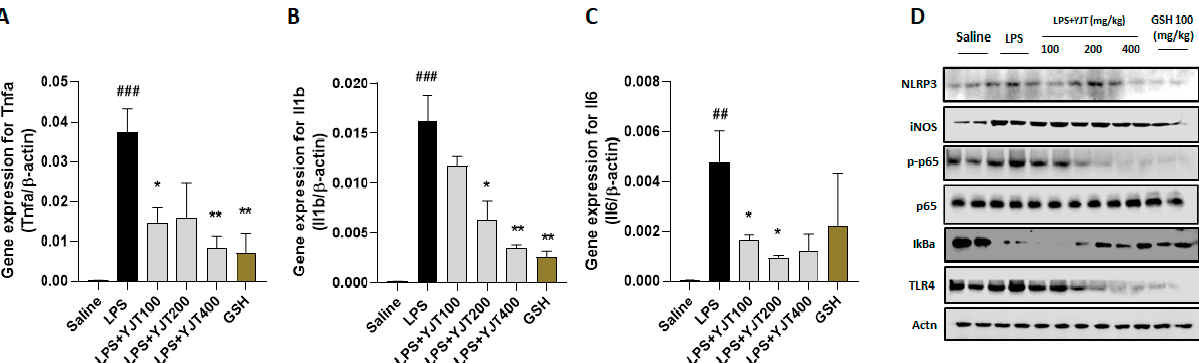
Figure 4. Western blot and gene expression analysis of LPS–induced hippocampal injury, resulting inflammatory signaling pathways. Mice were sacrificed and brain tissues were removed after the final LPS injection. The hippocampus was isolated from brain tissue and prepared either protein lysates ( n = 6–9 to each group) or mRNA ( n = 4–6 to each group) samples were prepared for further analysis. qPCR analysis was used to determine the mRNA expression levels of pro–inflammatory cytokines including ( A ) Tnfa, ( B ) Il1b, and ( C ) Il6. Western blot analysis of ( D ) NLRP3, iNOS, p– p65, p–65, I κ B α , TLR4, and actinin were performed ( n = 4 to each group). The data were expressed as mean ± SEM. ## p < 0.01 and ### p < 0.001 for Con vs. LPS, * p < 0.05, and ** p < 0.01 for LPS vs.